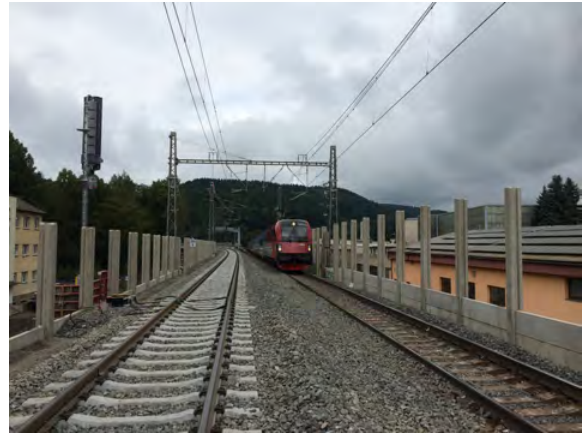
Figure 3. Installation of noise barriers in Usti nad Orlici